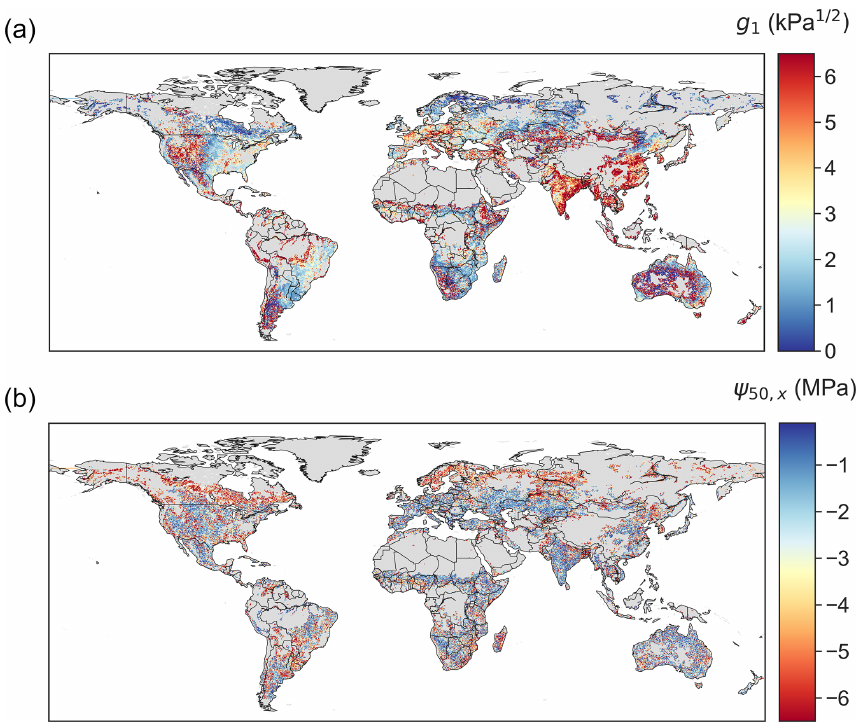
Figure 3. Global maps of (a) g 1 and (b) ψ 50 , x retrieved using model–data fusion. The posterior mean of each pixel is plotted.